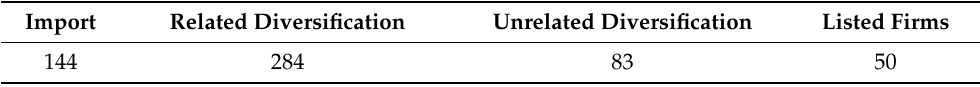
Table 1. Classification table of firms.